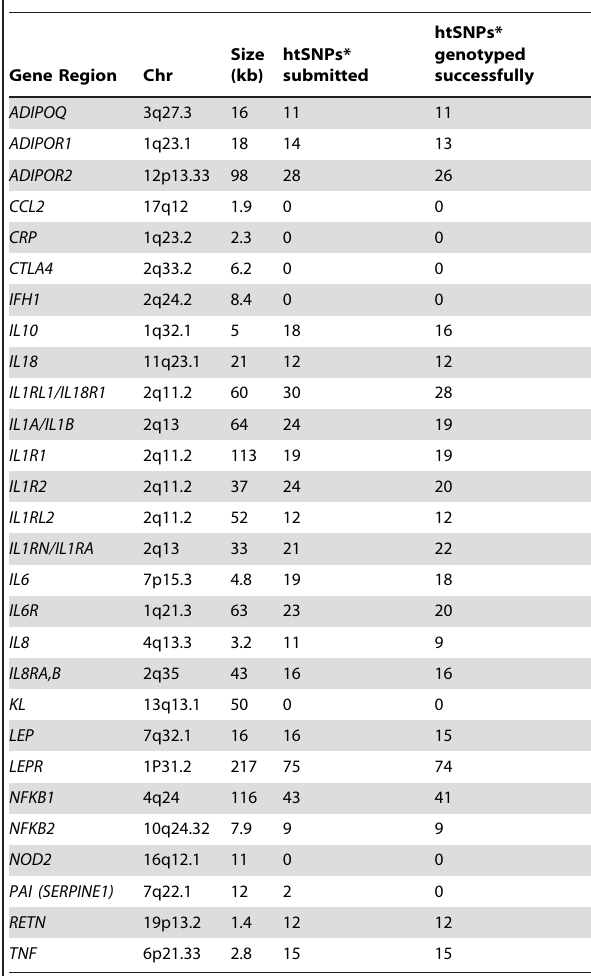
Table 2. Candidate gene